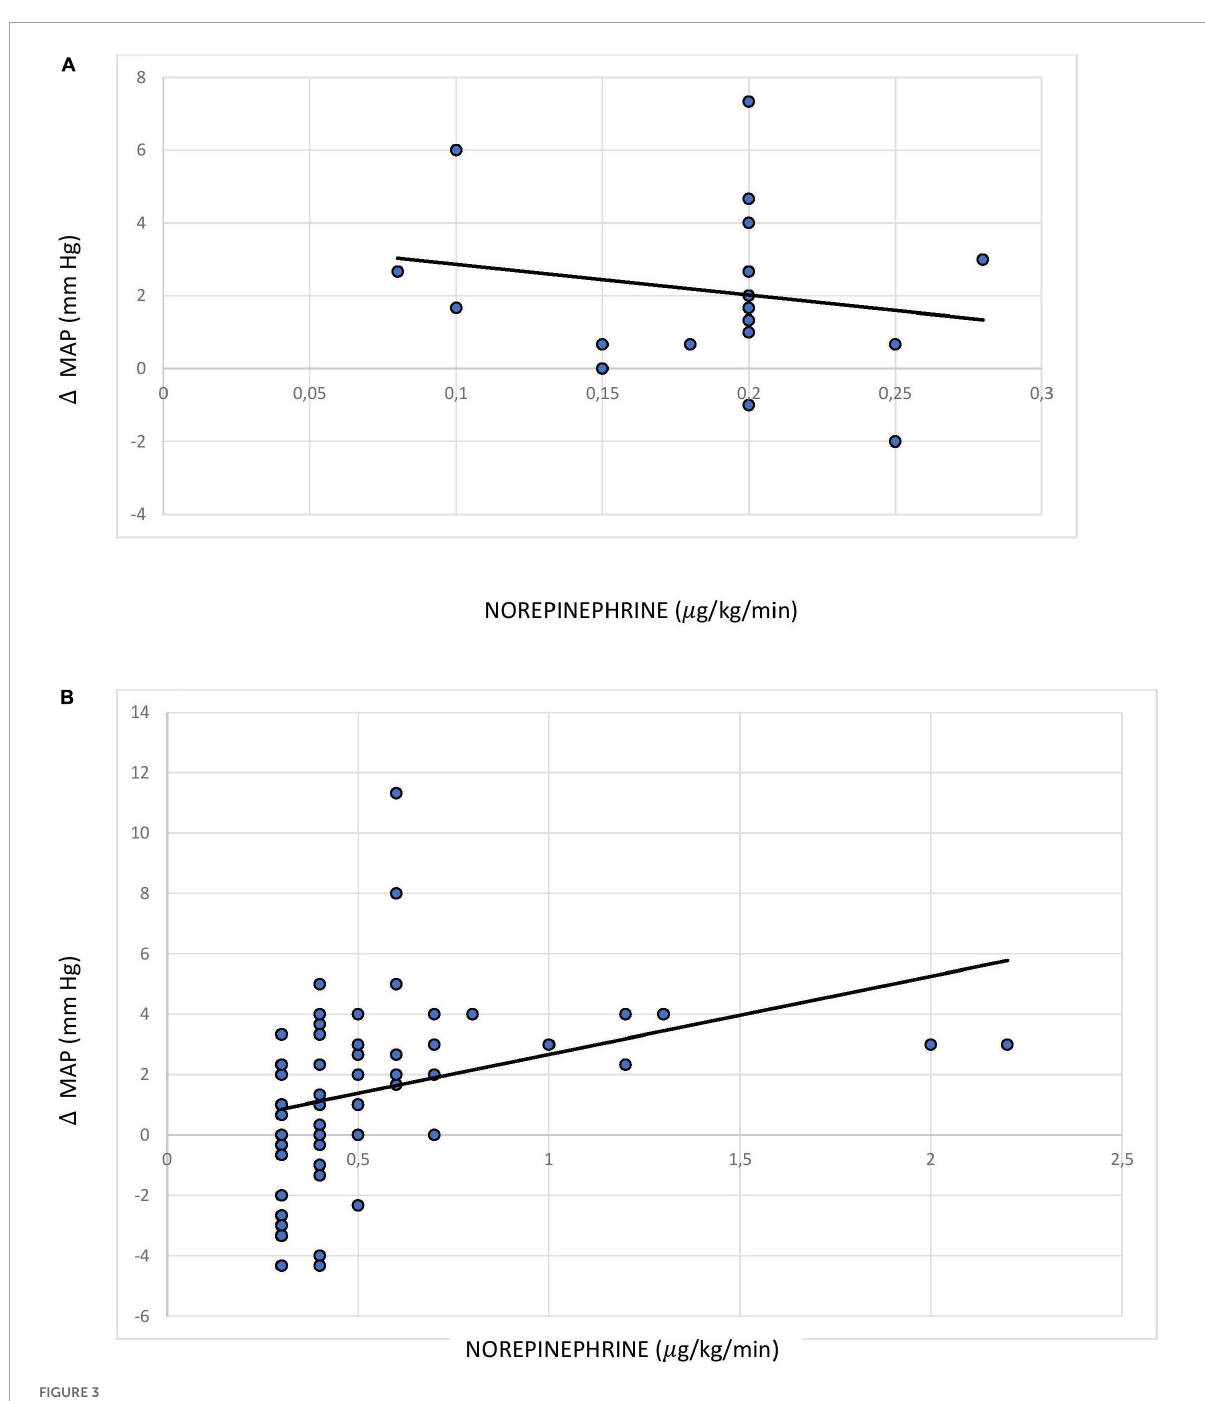
at the femoral arterial site when measured simultaneously with the radial site (19–23), while those by Mignini and Antal have not observed this (24, 25). Among these, only the studies conducted by Dorman and Kim recruited a cohort of only septic shock